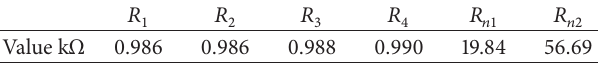
Table 2: Different insert resistance